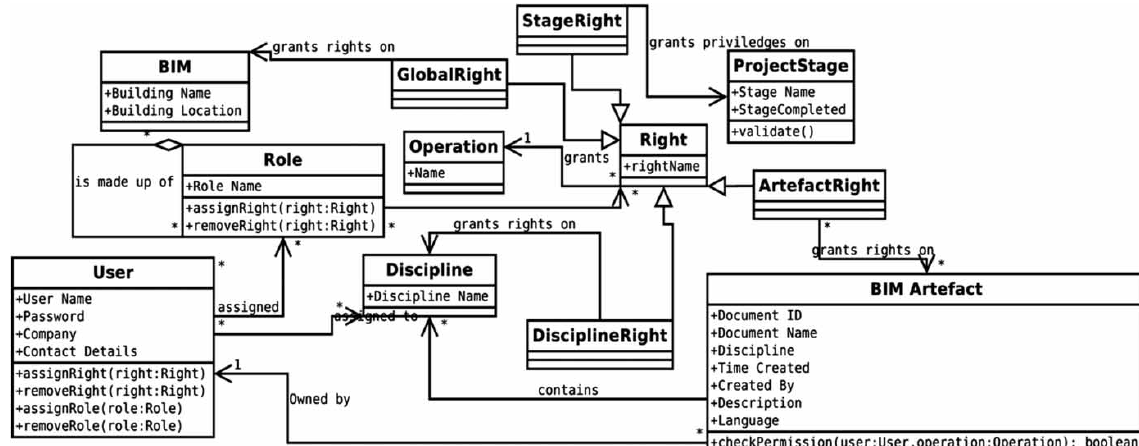
Fig. 7. Implementation of users, disciplines and